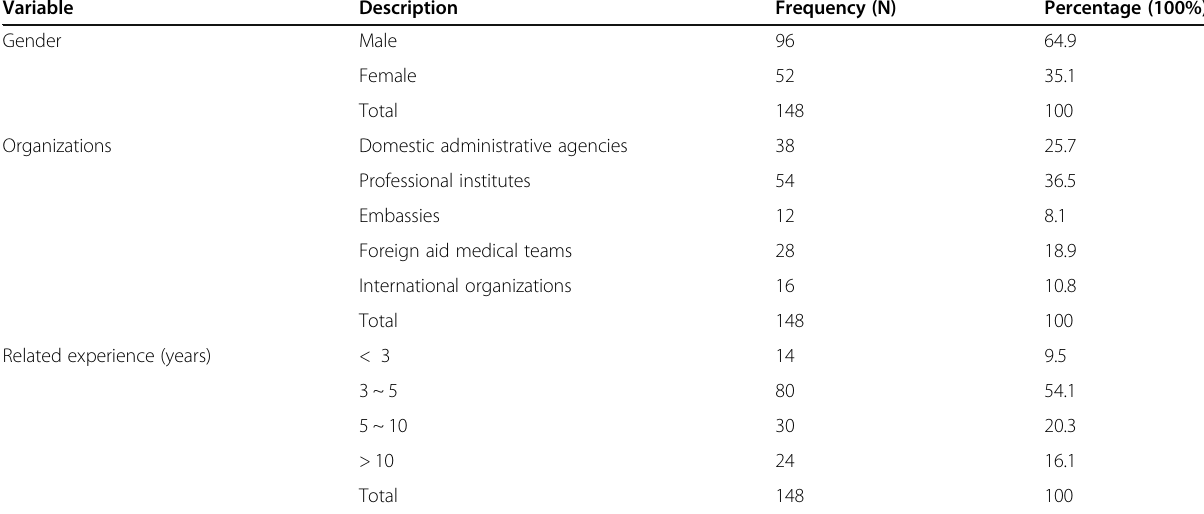
Table 1 Demographic information on respondents from five organizations related to China ’ s global health engagement